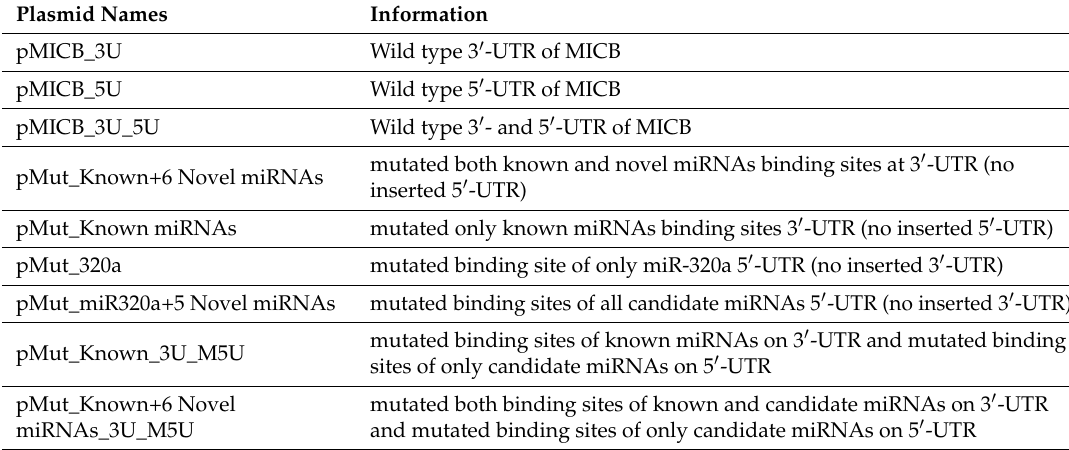
Table 1. List of plasmid